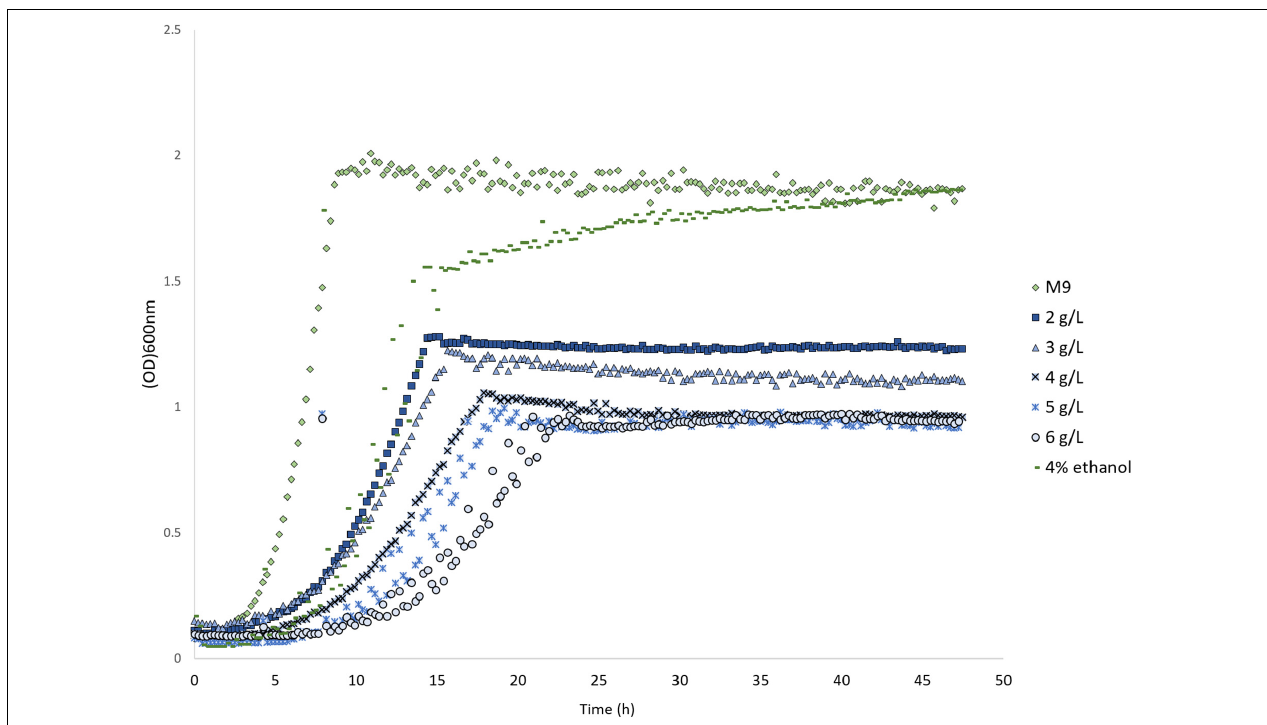
FIGURE 2 | Product inhibition of the melatonin cell factory. Growth inhibition of the E. coli host strain HMP1741 at different concentrations of melatonin. Data represent the average of triplicates. Ethanol was added to dissolve melatonin in the media. All media with different melatonin concentrations were adjusted to contain 4%